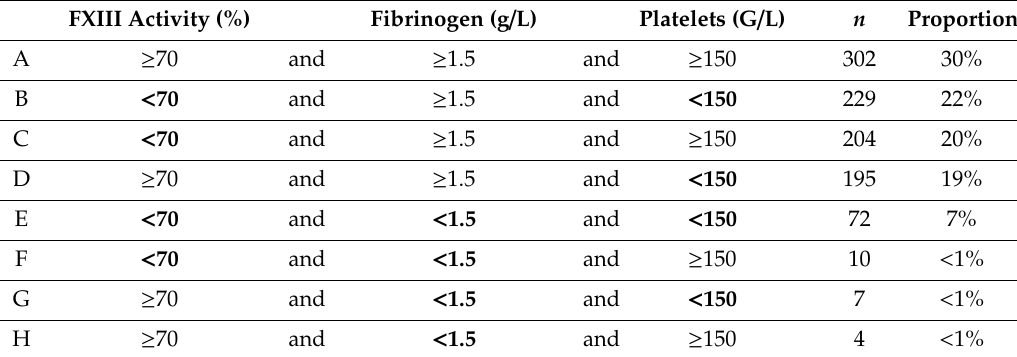
Table 2. Prevalence of combined deficiencies.